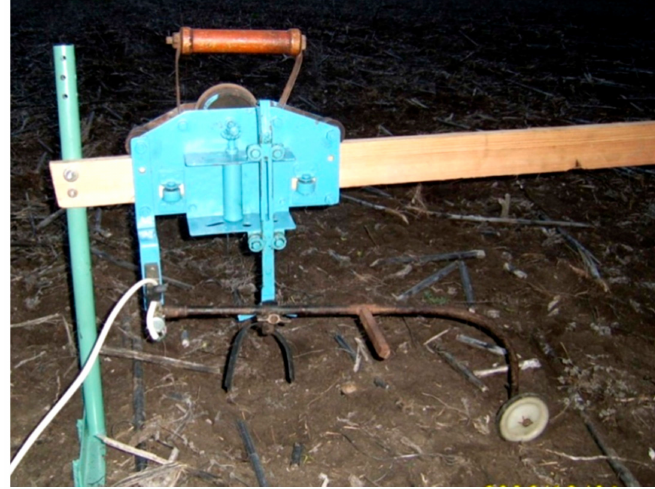
Figure 3. Device for measuring surface profile